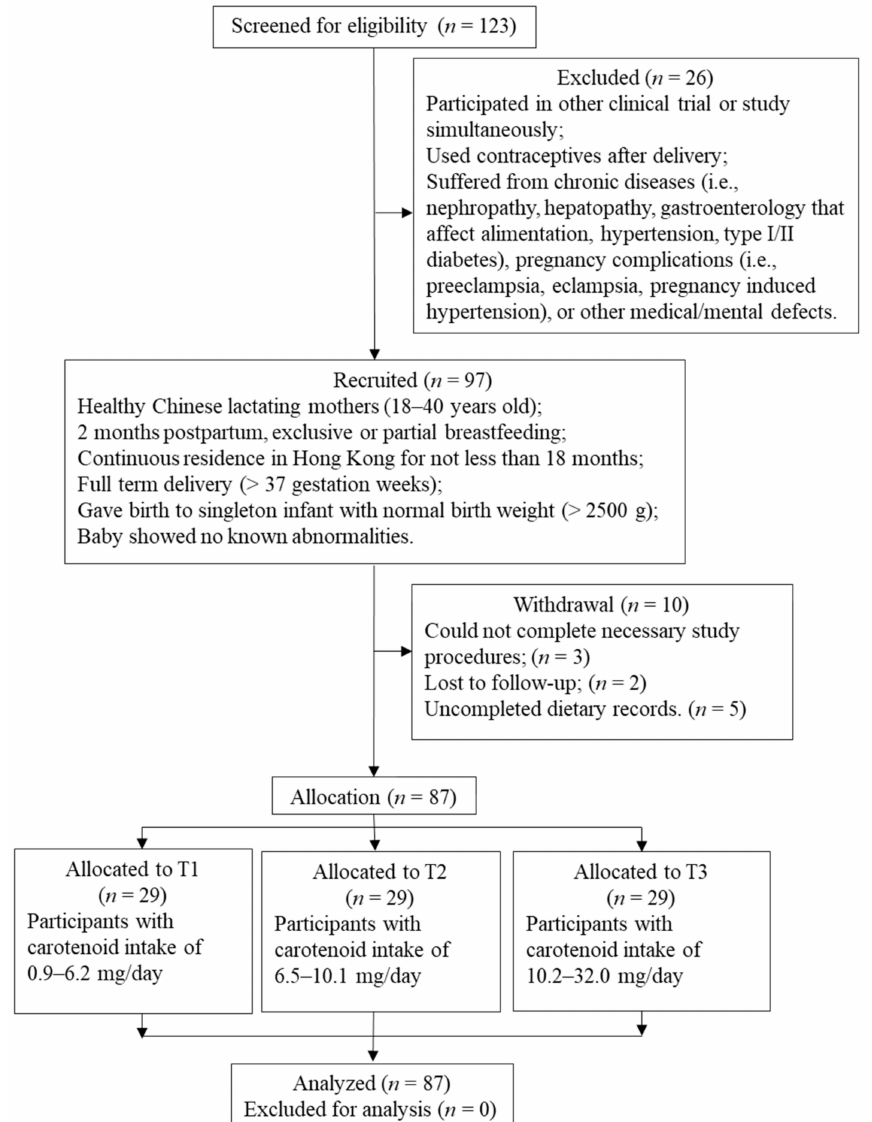
Figure 1. Subject recruitment flow chart of the